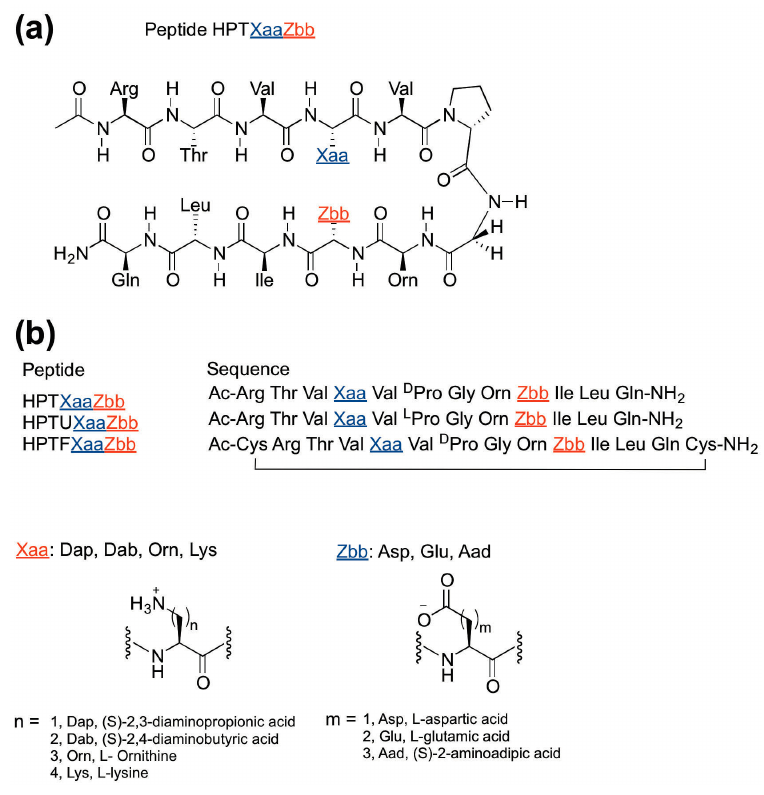
Figure 1. Design of peptides to study the effect of charged amino acid side-chain length upon swapping the charged amino acid positions in lateral ion-pairing interactions. ( a ) The chemical structure of the experimental HPTXaaZbb peptides; ( b ) The sequences of the experimental HPTXaaZbb peptides, the unfolded reference HPTUXaaZbb peptides, and the folded reference HPTFXaaZbb peptides.